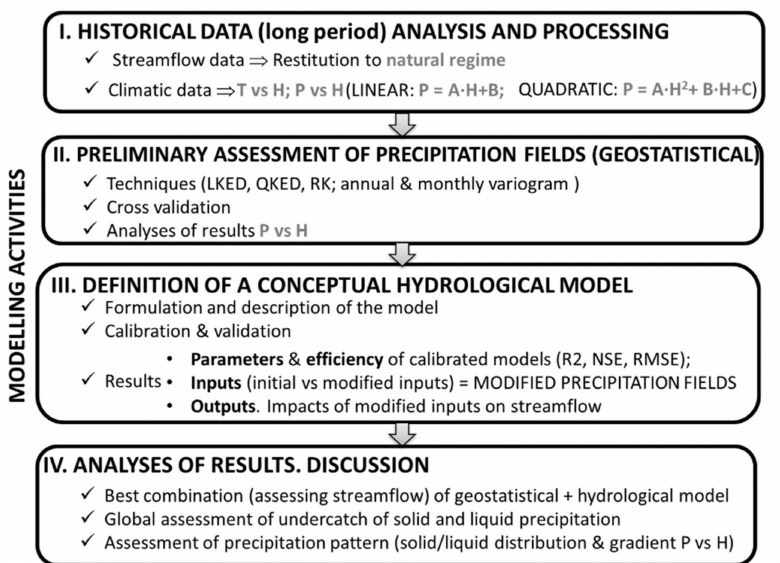
Figure 2. Flow chart of the methodology (T is temperature; H is elevation; P is precipitation; A, B, and C are the coe ffi cients of the equation; LKED and QKED are linear and quadratic kriging with external drift, respectively; RK is regression kriging; R 2 is the coe ffi cient of determination; NSE is the Nash–Sutcli ff e e ffi ciency; RMSE is the root-mean-square error; PBIAS is the percent